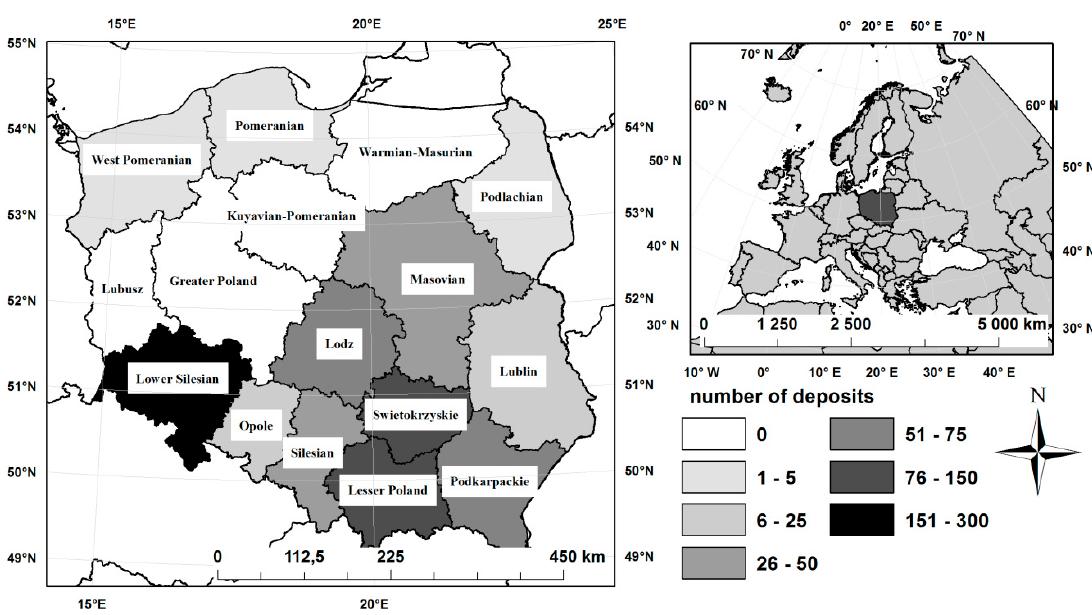
Figure 1. Dimension and crushed stone deposits in Poland.